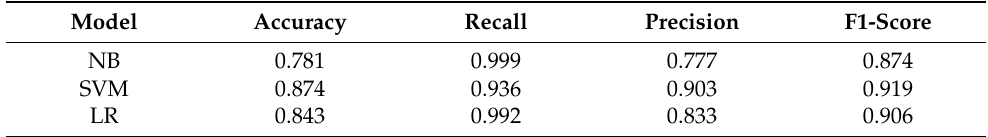
Table 4. Model evaluation of sentiment analyzer. Model Accuracy Recall Precision